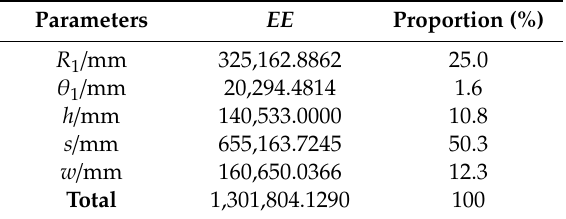
Table 4. Influence proportion of the optimized parameters on E max.